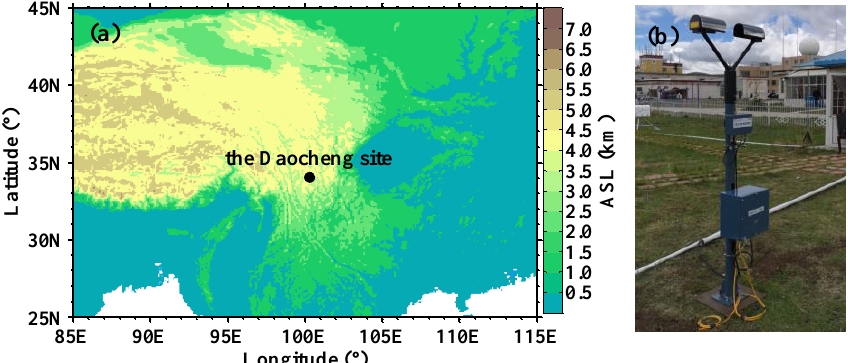
Figure 1. Location of the observation site (29.04° N, 100.30° E, 3800 m asl) ( a ) and the appearance of the disdrometer ( b ).